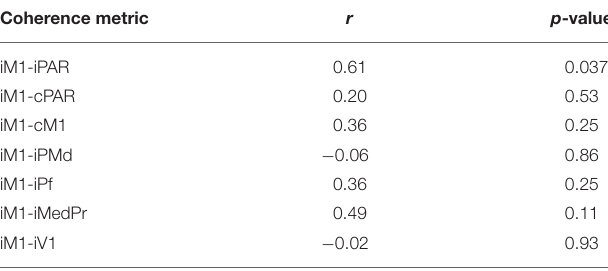
TABLE 3 | Baseline EEG prediction of training-related gain in visuomotor tracking. Coherence